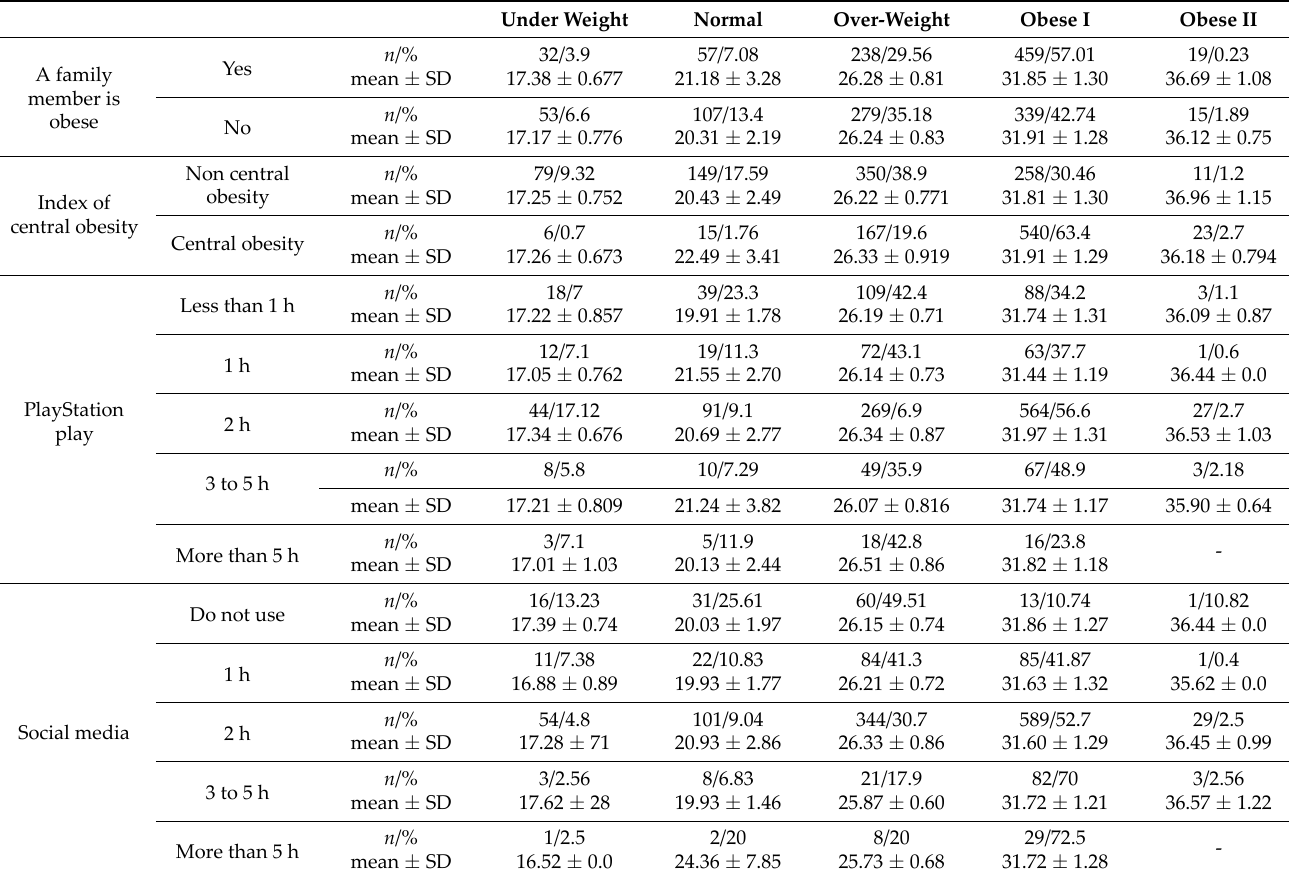
Table 4. Differences in body mass index according to health